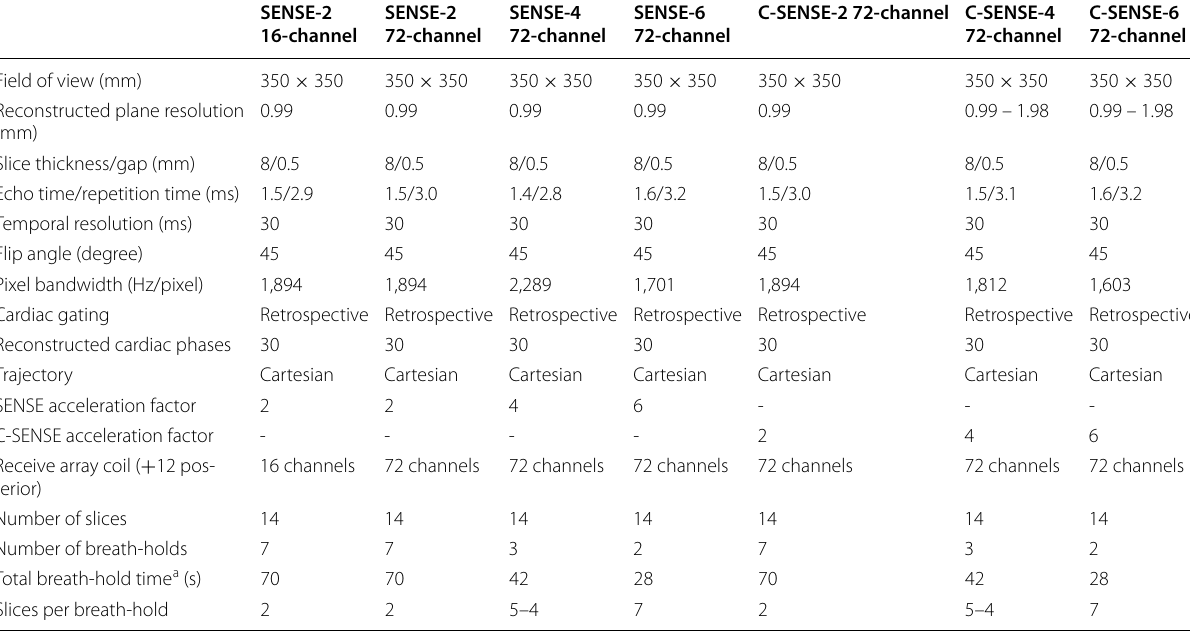
a Based on heart frequency of 60 beats/min . C-SENSE Compressed sensitivity encoding, SENSE Sensitivity